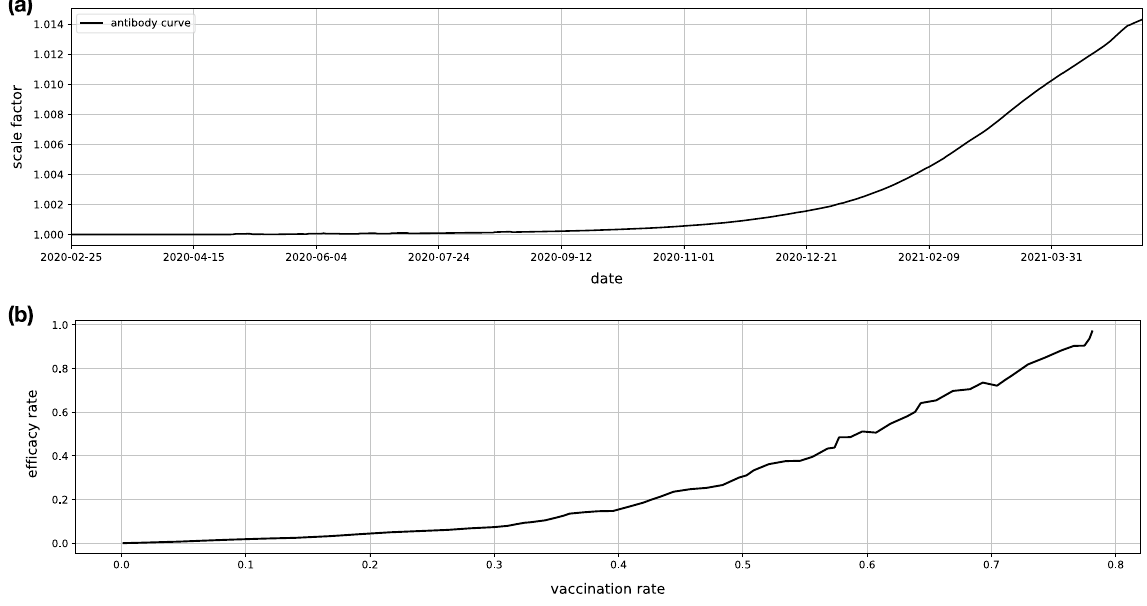
Figure 10. External factors. ( a ) Antibody curve which is computed from cumulative statistics on the antibody positive rates. ( b ) Vaccination efficacy curve obtained from Israel vaccination campaign data available at the time 24